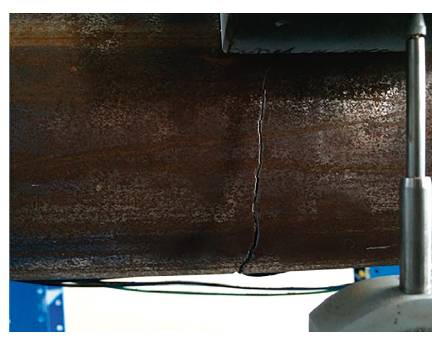
Figure 13: Brittle fracture of the steel casing of specimen